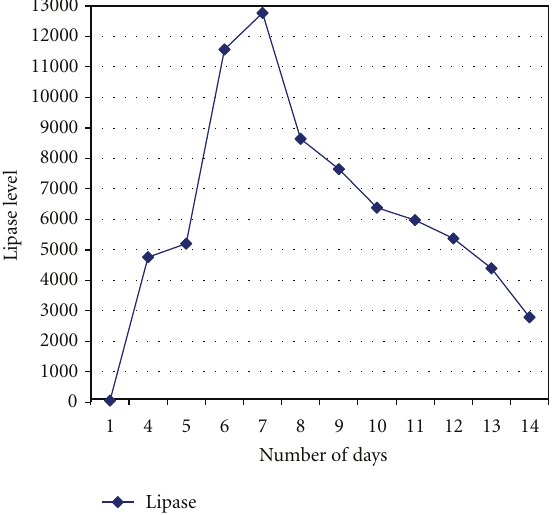
Figure 3: Pancreatic lipase levels of the patient which started to decline when hematoma started to